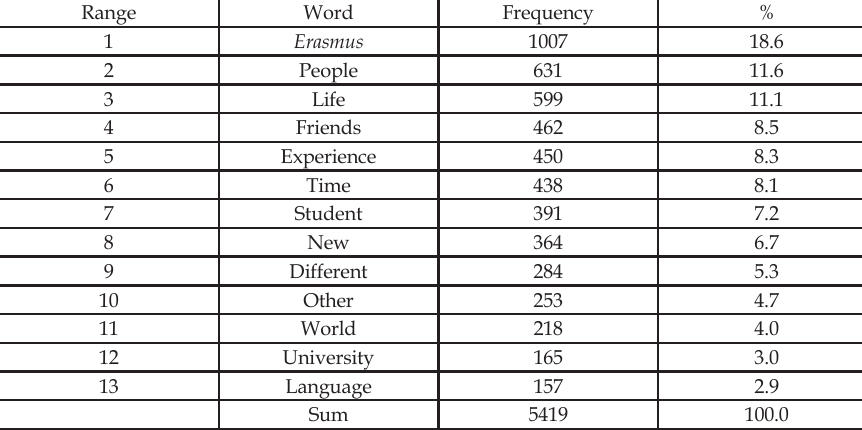
Tab. 3. The frequency distribution of the words used in Erasmus